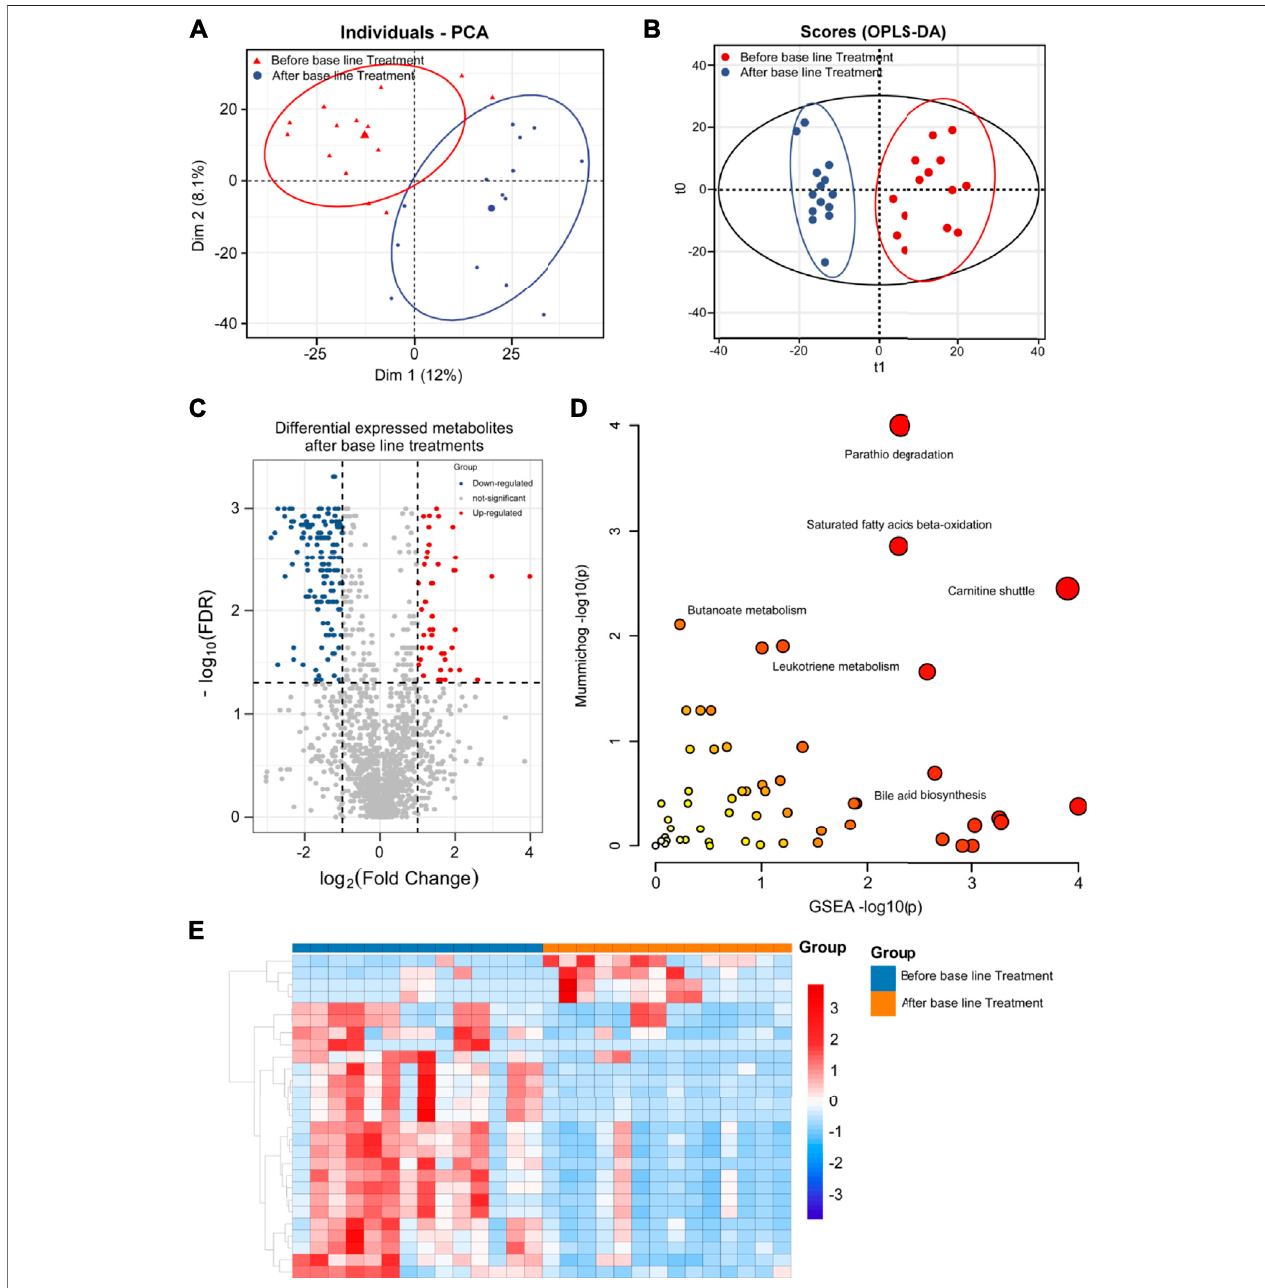
FIGURE 4 | Metabolomics analysis of breast cancer patients ’ serums between base-line chemotherapy and SST treatments. (A, B) PCA (A) and OPLS-DA (B) plots of the metabolites detected in serums of breast cancer patients between base-line chemotherapy and SST treatments (n (cid:1) 12 for SST group, n (cid:1) 14 for base-line chemotherapy group). (C) Volcanoplot showingtheDEMs identi fi ed inserums ofbreast cancerpatientsbetweenbase-linechemotherapyand SSTtreatments. (D) The bubble plot showing the enriched pathways ofDEMs identi fi ed in serums of breast cancer patients between base-line chemotherapy and SST treatments. (E) The heatmap illustrating the levels of DEMs identi fi ed in serums of breast cancer patients between base-line chemotherapy and SST treatments; each row represents one metabolite, and each column represents one sample.